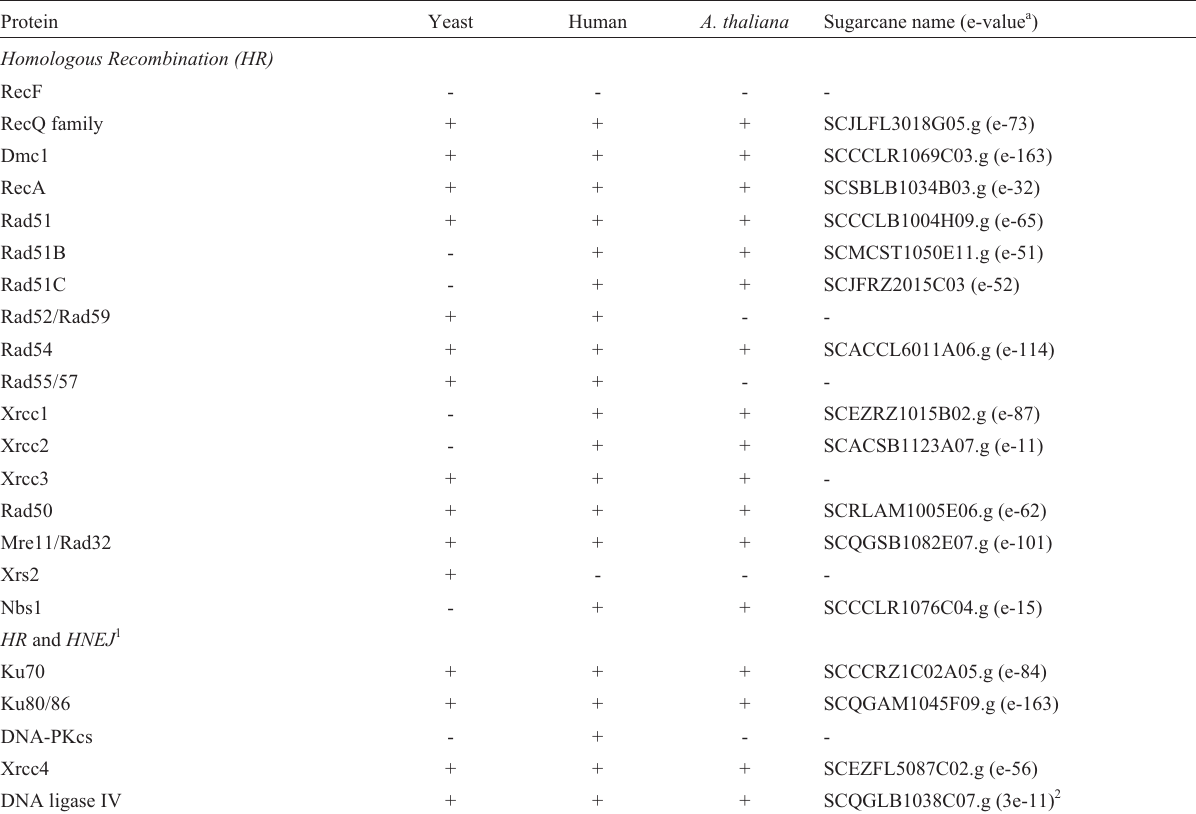
Table V - Presence (+) or absence (-) of Recombinational Repair Proteins and their homologues in different organisms. Protein